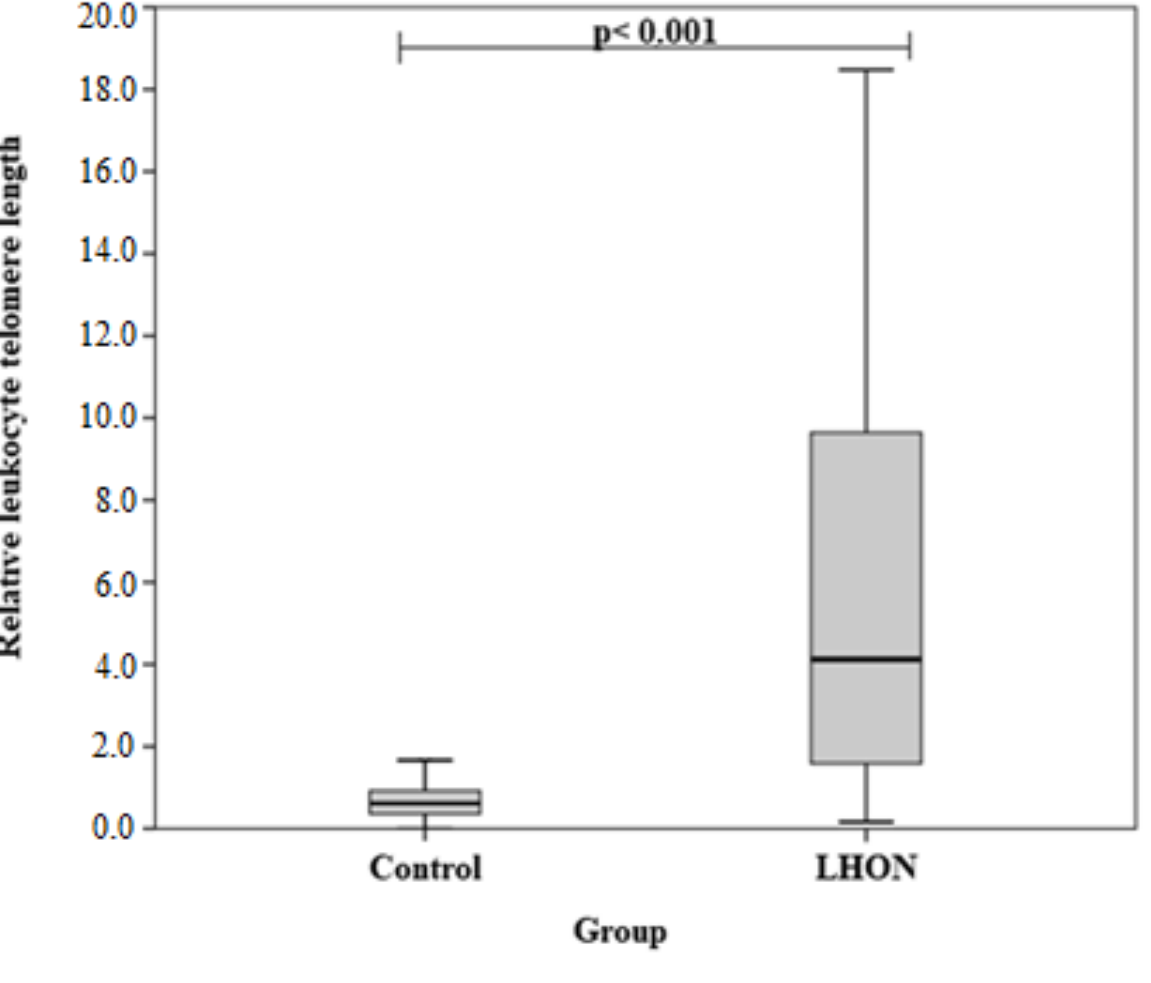
Figure 1. Relative length of leukocyte telomeres in LHON and control groups. The Mann-Whitney U test was used.